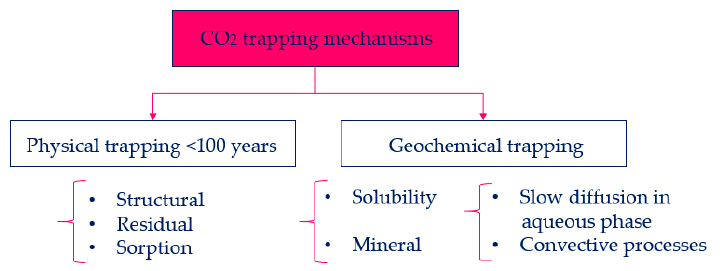
Figure 2. Schematics of CO 2 trapping mechanisms (modified after [24]).